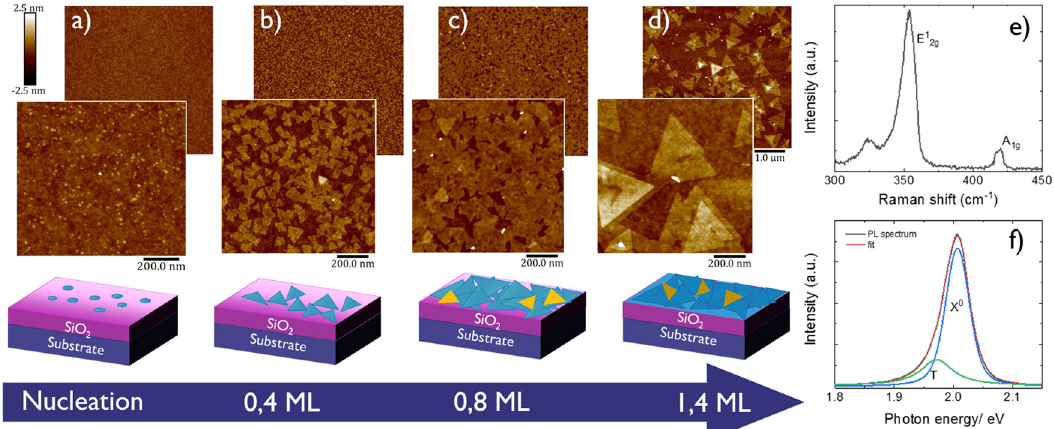
Fig. 6 Characterization of as-grown WS 2 on Si/SiO 2 by MOCVD. a – d AFM images at various stages of the growth (the layer thickness in each step is given based on RBS analysis); e representative Raman spectrum of a representative monolayer sample; f photoluminescence (PL) measurements of a representative monolayer sample, showing neutral exciton (X0) and trion (T)